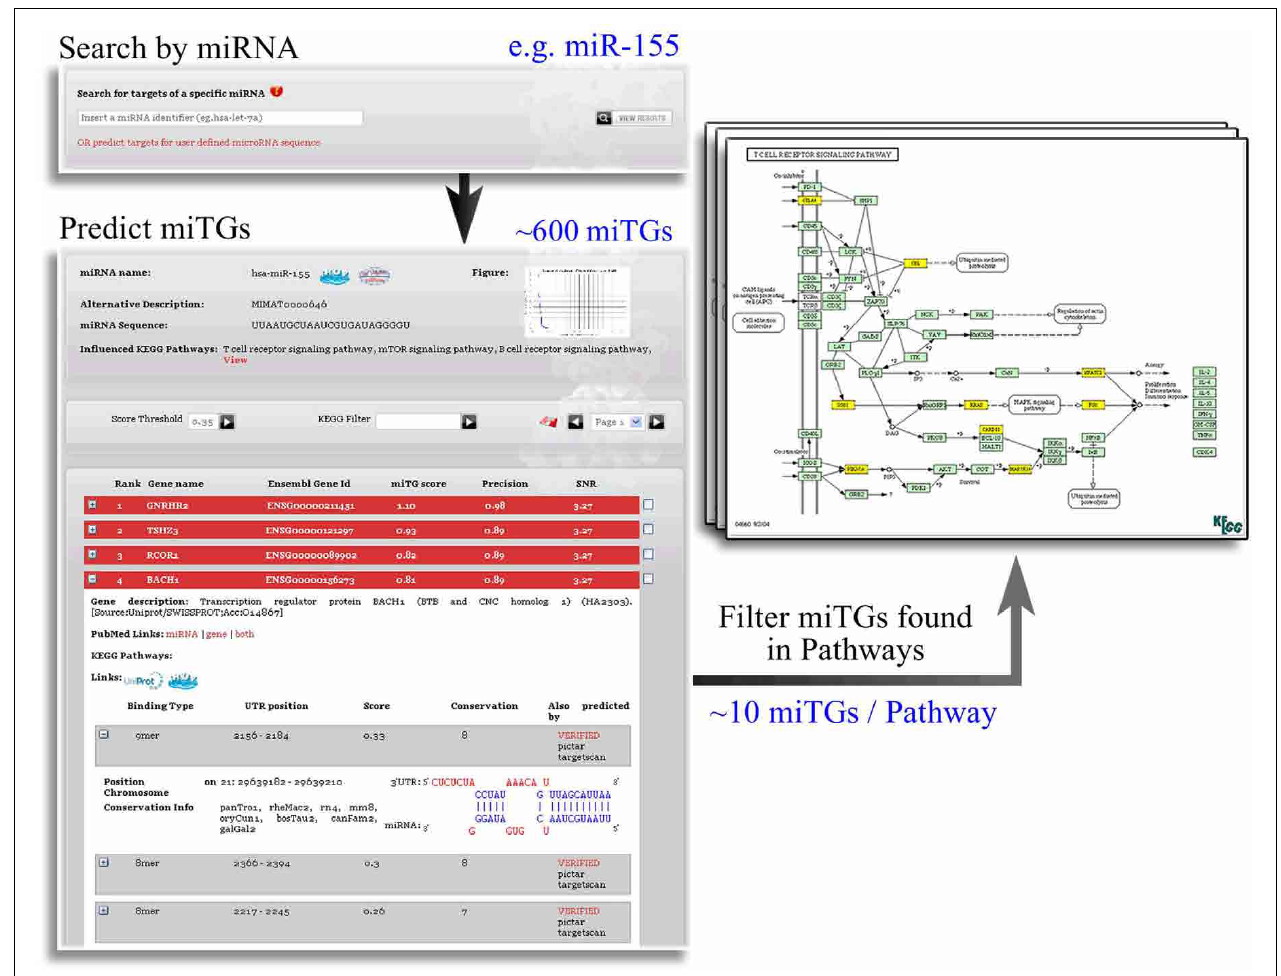
the biological pathways enriched this set.The functional relation and interplay of the miTGs are provided in a graphically annotated network where only those few targets of the specific miRNA, implicated in the process of interest, are presented instead of the usually overwhelming list of predicted miTGs.The results of this enrichment analysis focus the set of targeted genes to a few pathways and usually increase prediction